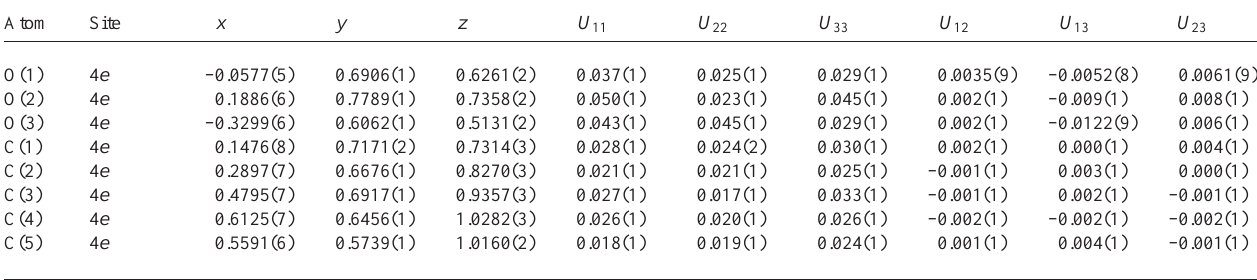
Table 3. Atomic coordinates and displacement parameters (in Å 2 )